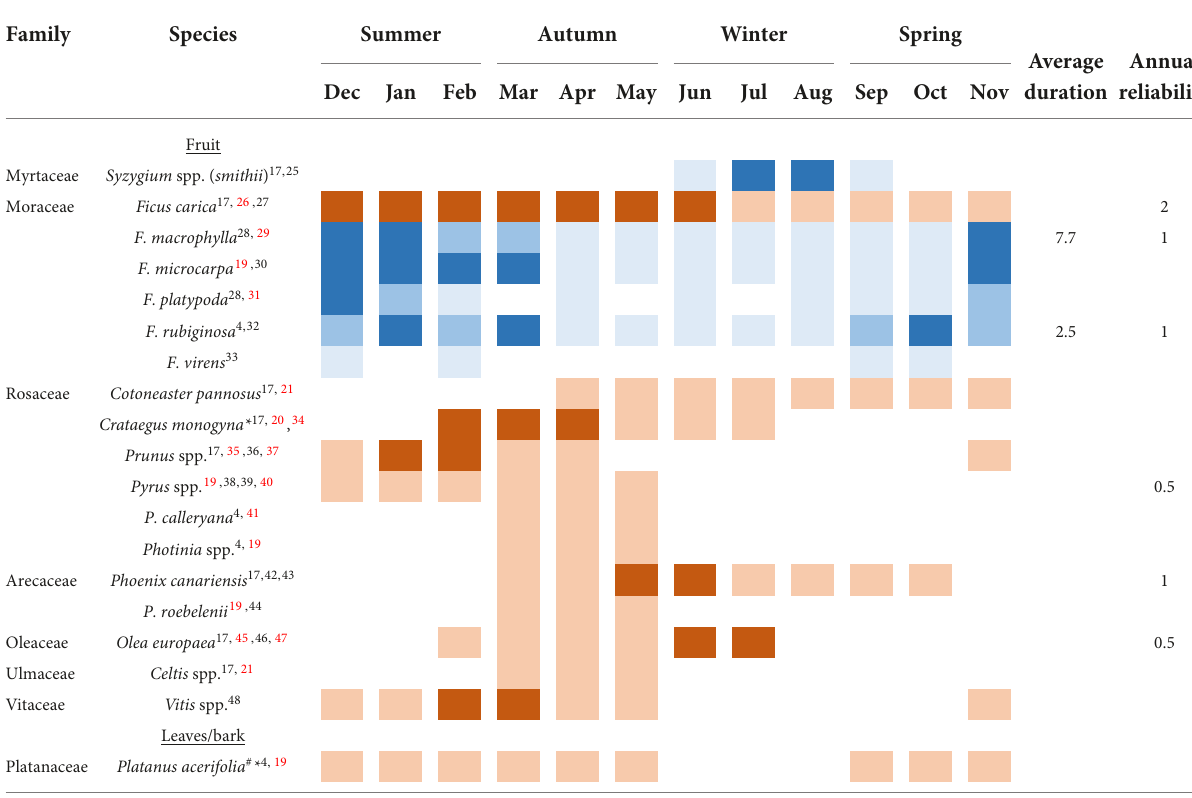
TABLE 2 The fruiting phenology of the food plant species visited by ( n = 9) GPS tracked Pteropus poliocephalus in the Adelaide region between Dec 2019 and May